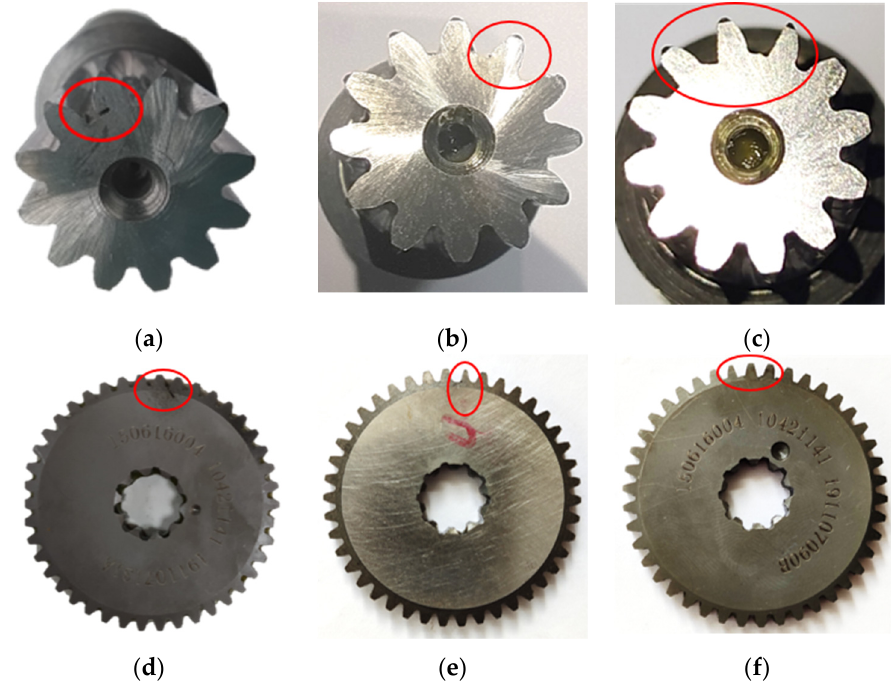
Figure 4. Fault picture. ( a ) Sun gear tooth root crack, ( b ) sun gear single tooth surface wear, ( c ) sun gear multi-tooth surface wear, ( d ) planetary gear tooth root crack, ( e ) planetary gear single tooth surface wear, ( f ) planetary gear multi-tooth surface wear.